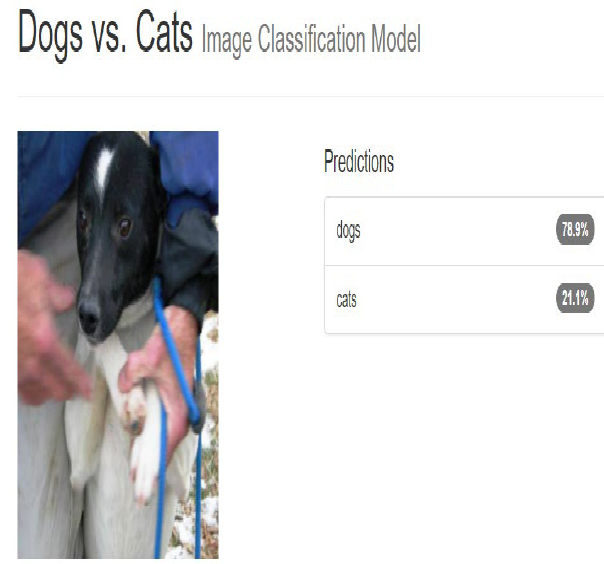
Figure 9. Image Classification Model